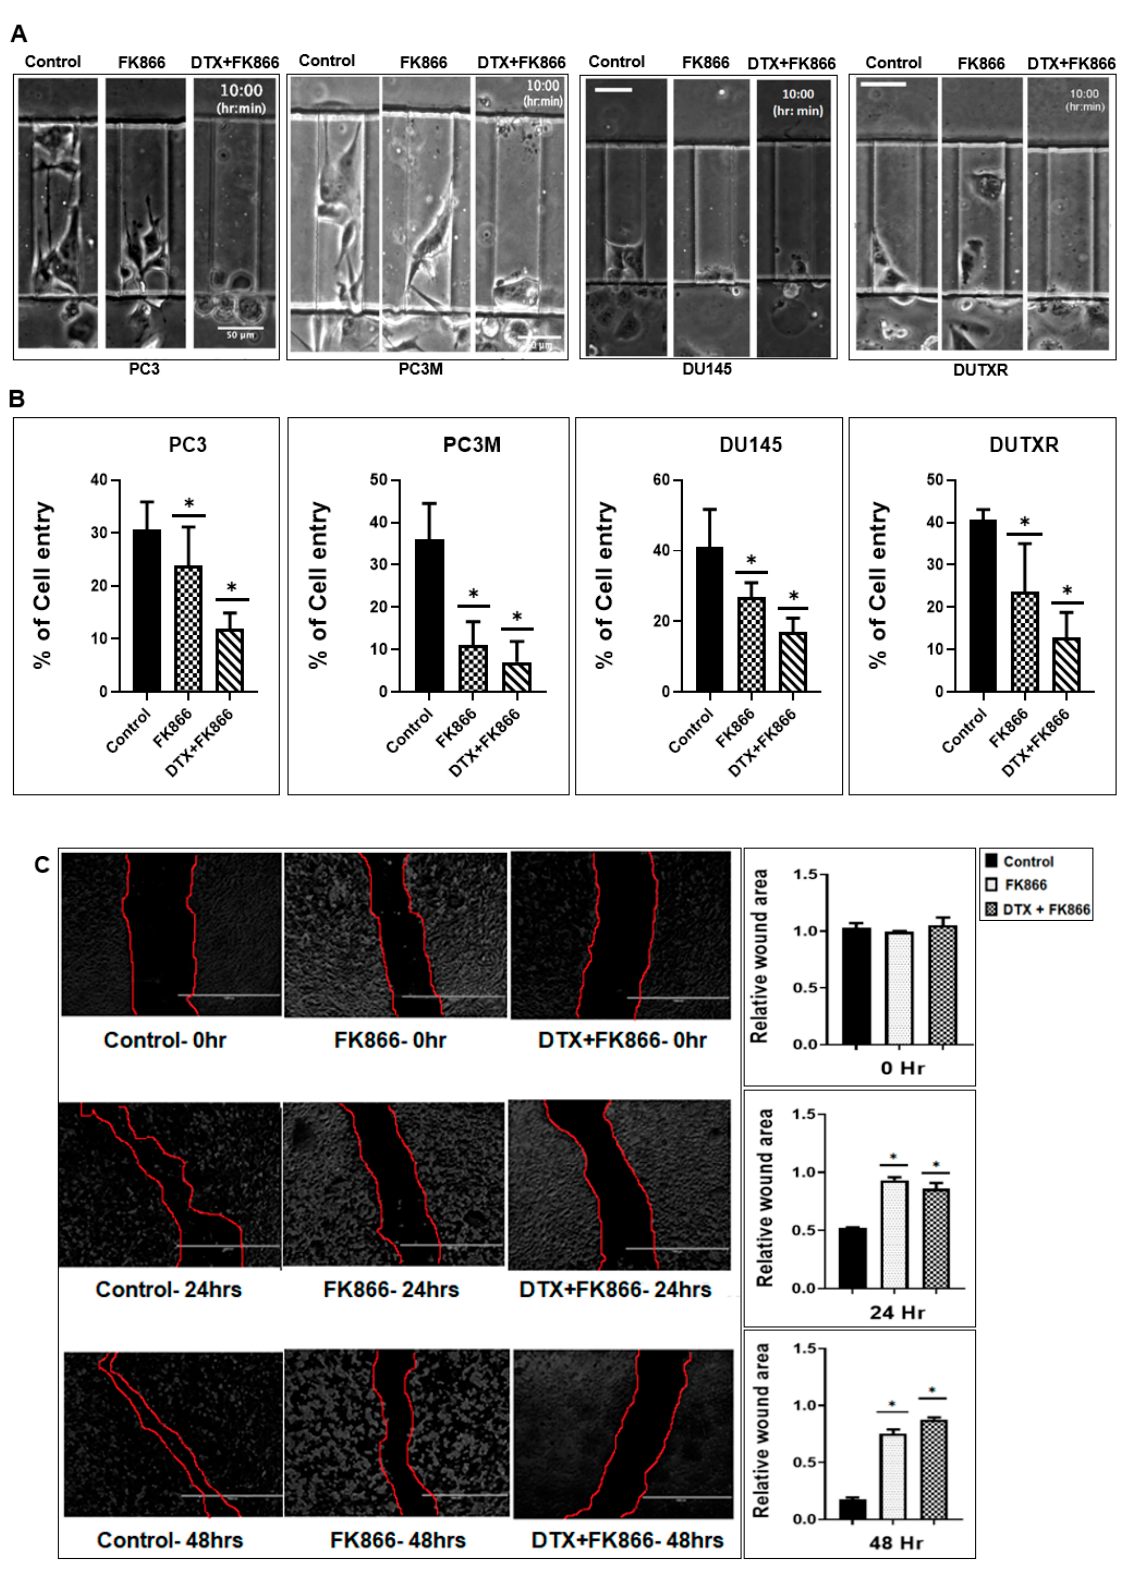
Figure 6. FK866 reduces cell migration and is potentially effective against metastasis and EMT transdifferentiation in lethal PCa. ( A ) Representative images of the control, FK866, and DTX + FK866- treated prostate cancer cells migrating through 50 µ m wide µ -channels. The fabrication of a µ -channel assay is described in the Methods section. Reduced cell entry into channels indicates a more